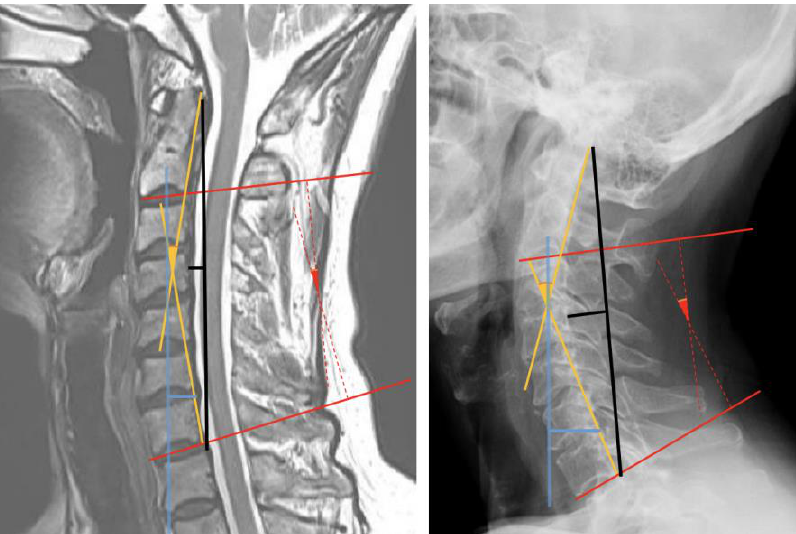
Figure 1. Measurements of cervical alignment shown on a magnetic resonance image (left image) and a radiograph (right image). The solid and dotted red lines indicate measurements of the C2-7 Cobb angles. The yellow solid lines indicate measurements of the C2-7 absolute rotational angle. The black solid lines indicate measurements using Borden’s method. The blue solid lines indicate measurements of the C2-7 sagittal vertical